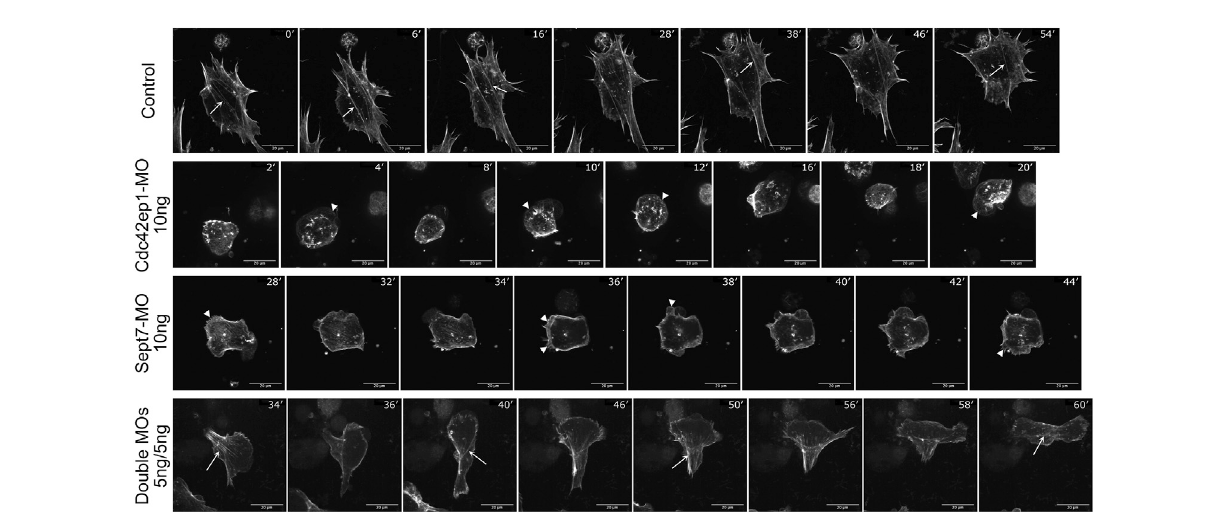
FIGURE 6 Septin fi laments regulate persistent cell migration by regulating actin dynamics. Timelapse images of control, Cdc42ep1 knockdown, Septin7 knockdown, and double knockdown neural crest cells were shown. While actin fi laments were assembled along similar orientations in control cells(arrows),10 ngofCdc42ep1-MOorSeptin7-MO disruptedtheformationofactinstress fi bers.Concurrently,membraneprotrusionswereformedat random orientations (arrowheads). When 5 ng of both Cdc42ep1-MO and Septin7-MO were injected, neural crest cells frequently changed the orientation of their actin stress fi bers (arrows) and the direction of migration. Scale bar = 20